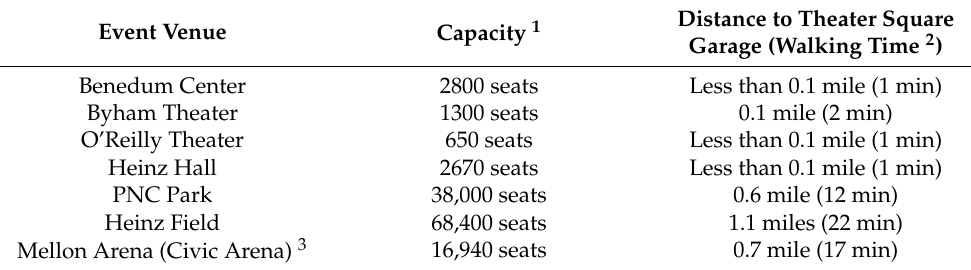
Figure 1. Locations of parking garages and major event venues in downtown Pittsburgh. Notes : Theater Square Garage is pinned in the middle of the map. Other garages are indicated as P . Major event venues are indicated as stars. 1 mile = 5280 feet = 1609 m. Map data © 2021 Google. Table 1. Capacity and distance information of major event venues.